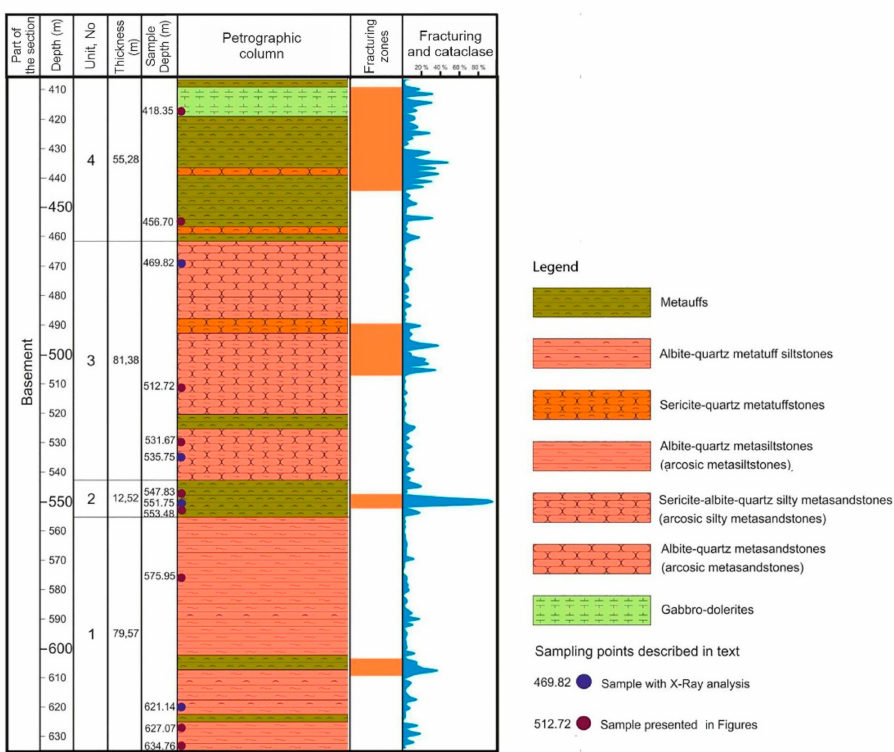
Figure 3. Basement